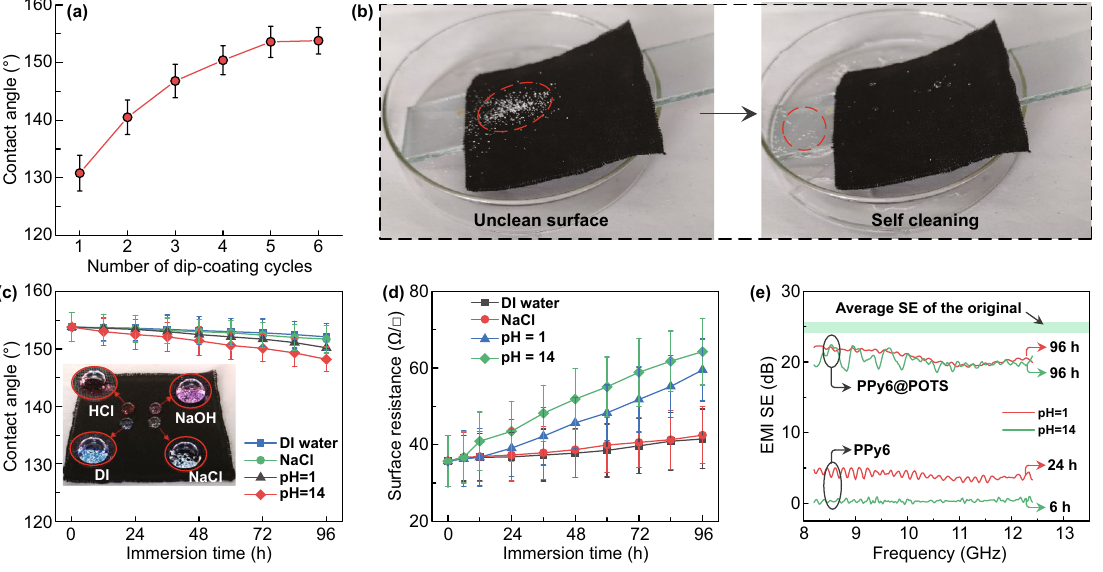
Fig. 4 Protections of POTS on multifunctional PPy n @POTS fabrics. a Water contact angle of PPy n @POTS fabrics. b Self-cleaning process of PPy6@POTS fabric. Dashed red cycles indicate the position of dust. c Water contact angle and d surface resistance of PPy6@POTS after immersion in DI water, NaCl, HCl (pH 1) and NaOH (pH 14) solutions for various times. The inset in c shows droplets of DI water, NaCl, HCl and NaOH on a PPy6@POTS fabric. An air cushion between the liquid and the fabric surface could be observed. e SE of PPy6@POTS and PPy6 fabrics after immersion in aqueous HCl (pH 1) and NaOH (pH